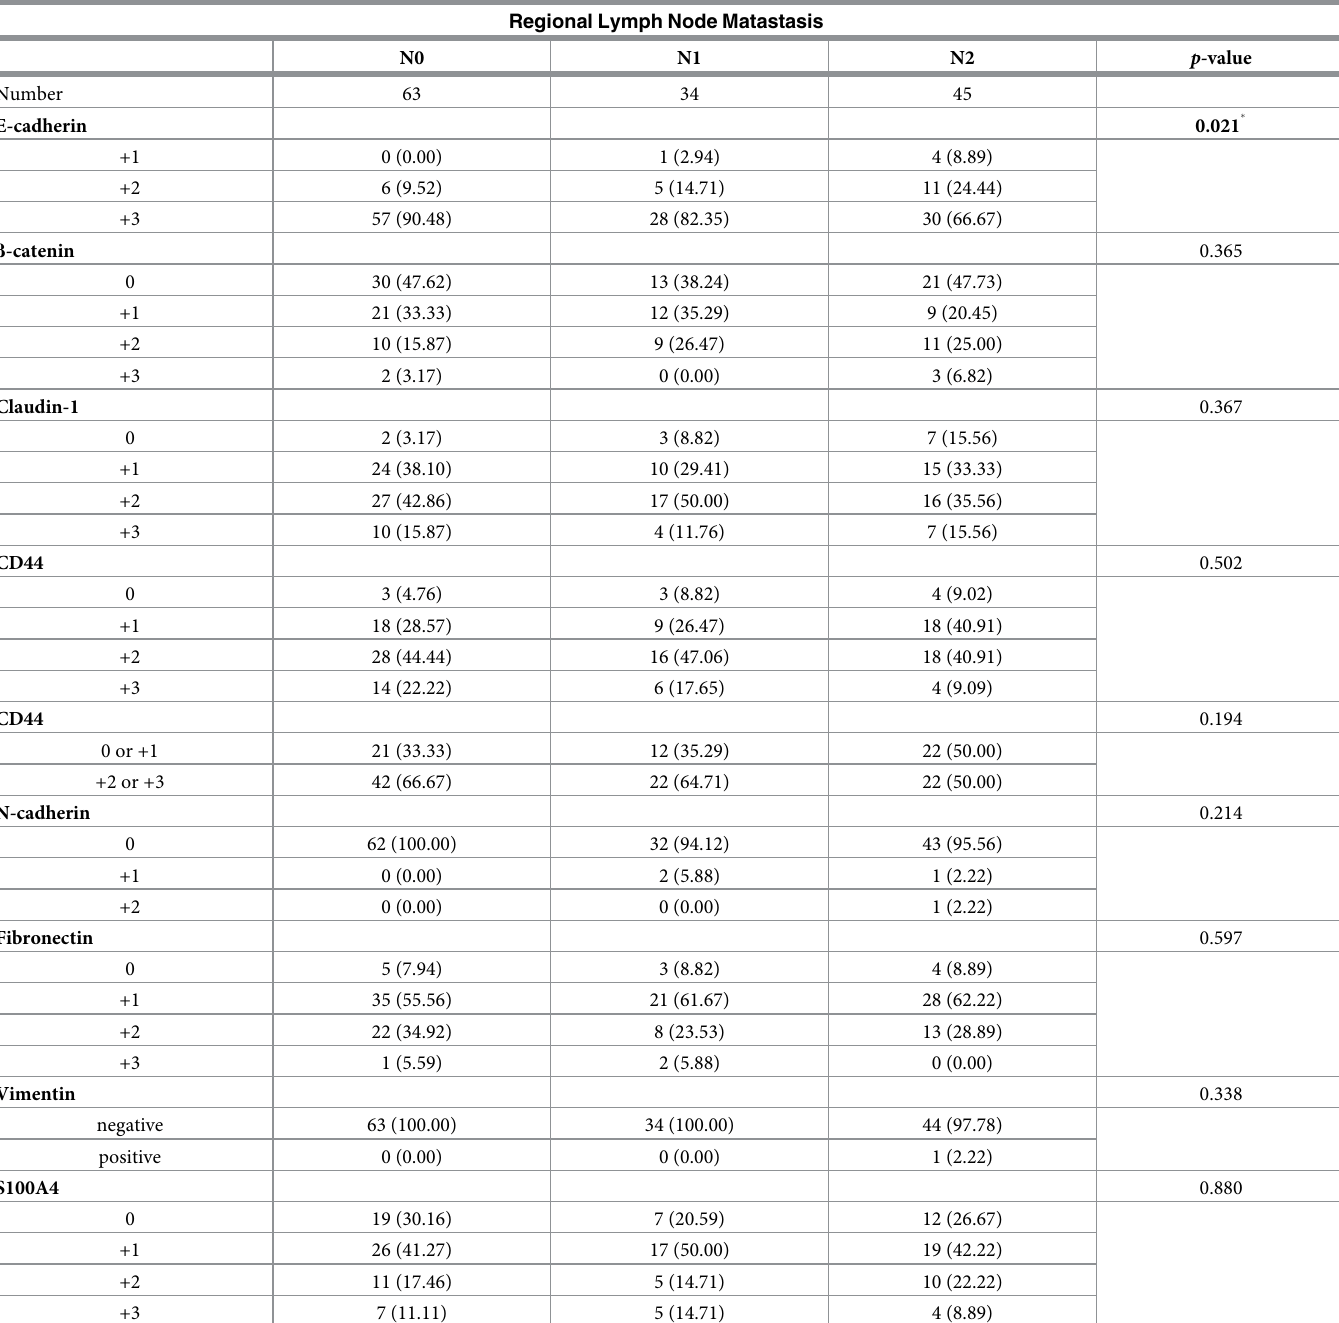
Table 6. IHC expression of EMT-related markers vs . regional lymph node metastasis.